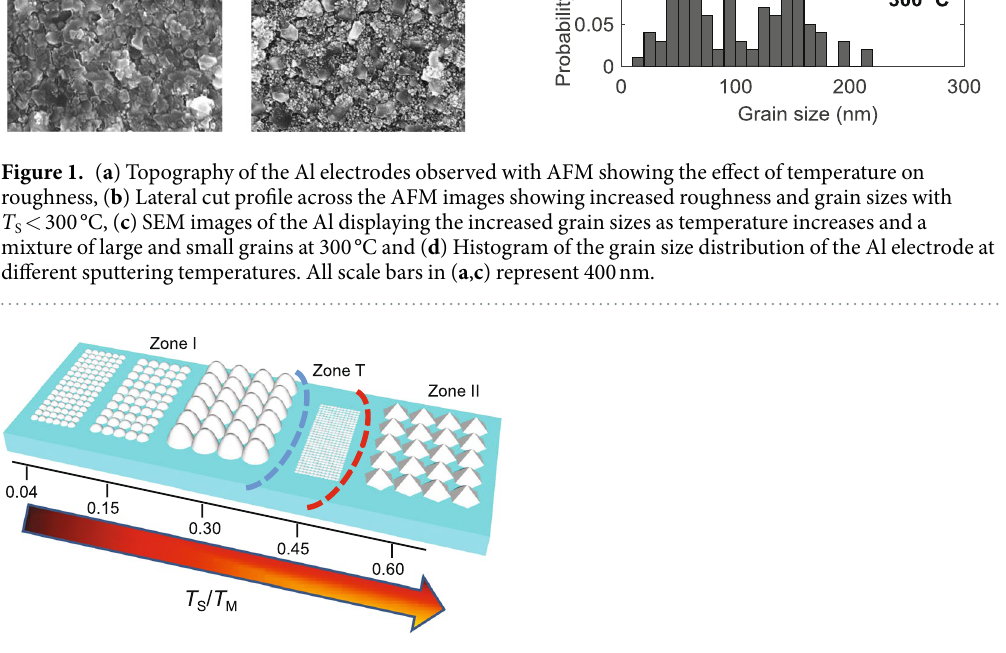
is less than 20° as the surface does not have the optimum roughness to promote the homogeneous c -axis inclina- tions and the grains re-orient in the more energetically favorable c -axis oriented direction. The difference in Φ for T S = 25 °C is caused by sample positioning in the XRD scans and has no effect on determining Ψ .